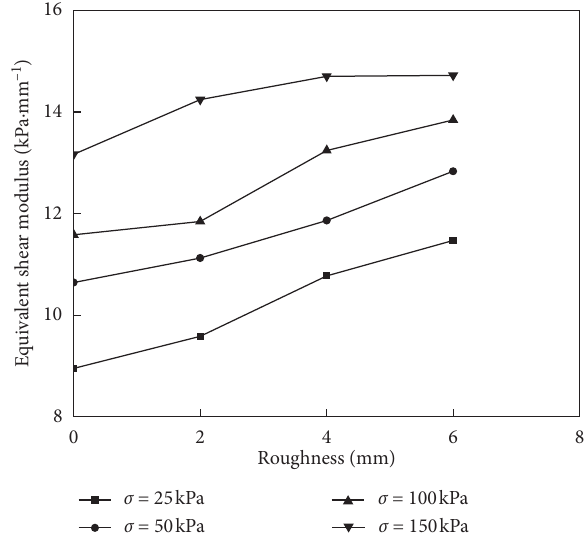
Figure 14: Relationship between equivalent shear modulus and roughness.